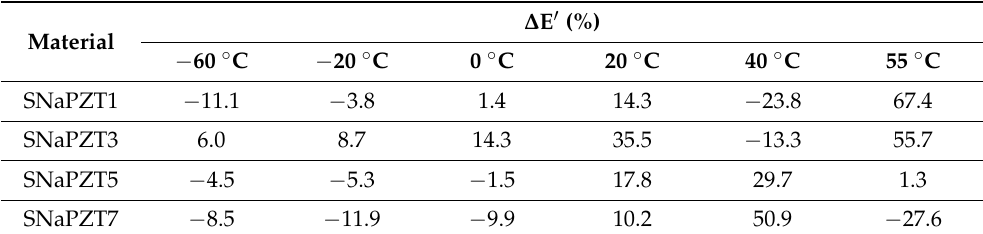
Table 3. Percentage variations of storage modulus (E (cid:48) ) in terms of temperature (obtained via DMA) for SNaPZT# films, considering values of SNa0 film as